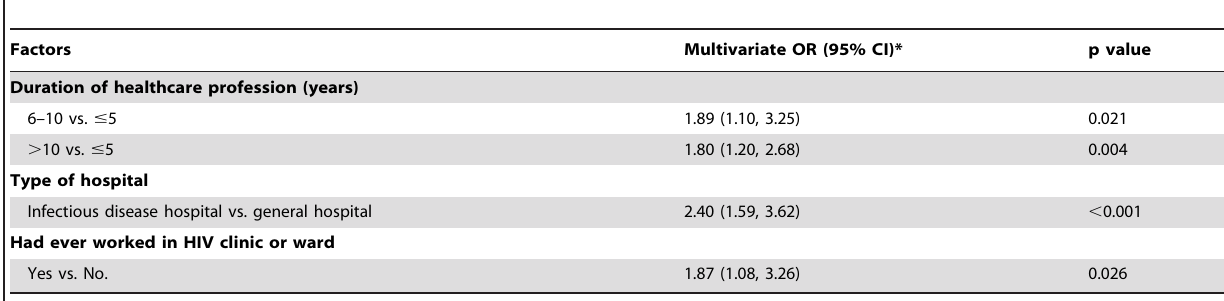
Table 3. The associations of LTBI 1 with potential factors in multivariate logistic regression model.